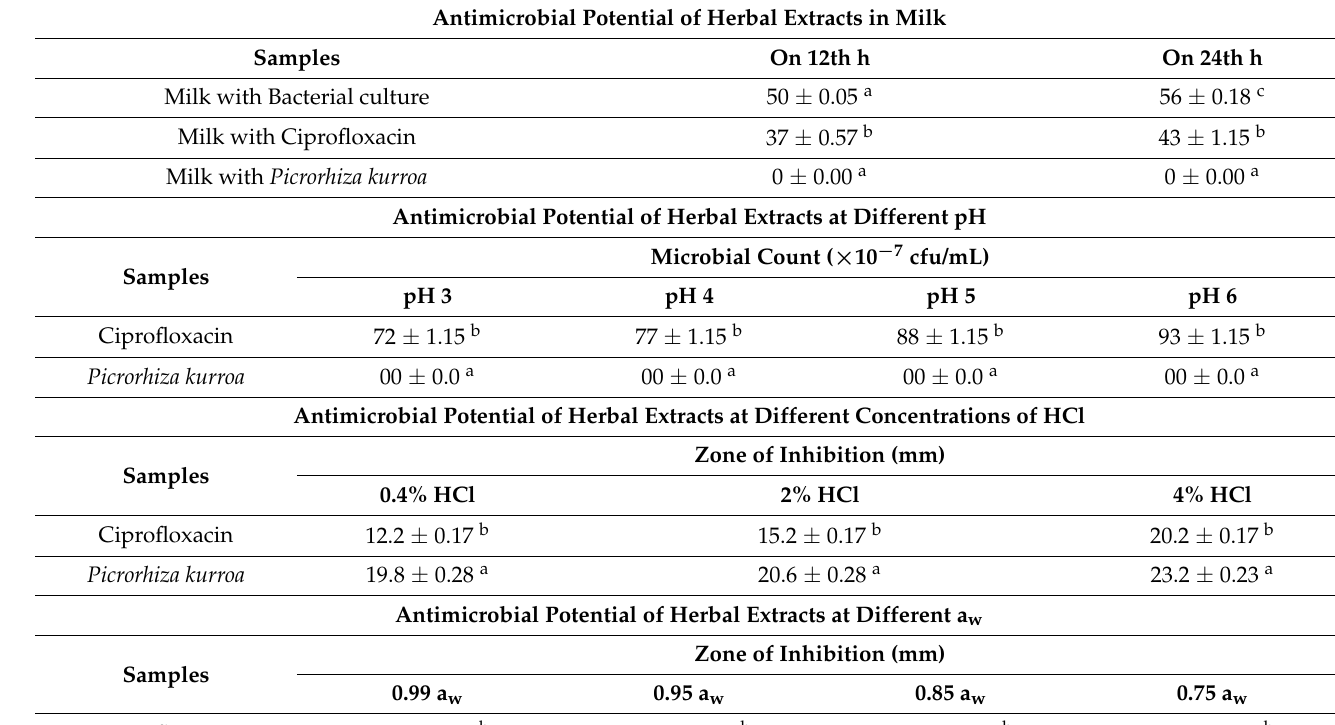
Table 2. The antimicrobial activity of P. kurroa against Yersinia enterocolitica in skim milk at different pH, acidity, and a w